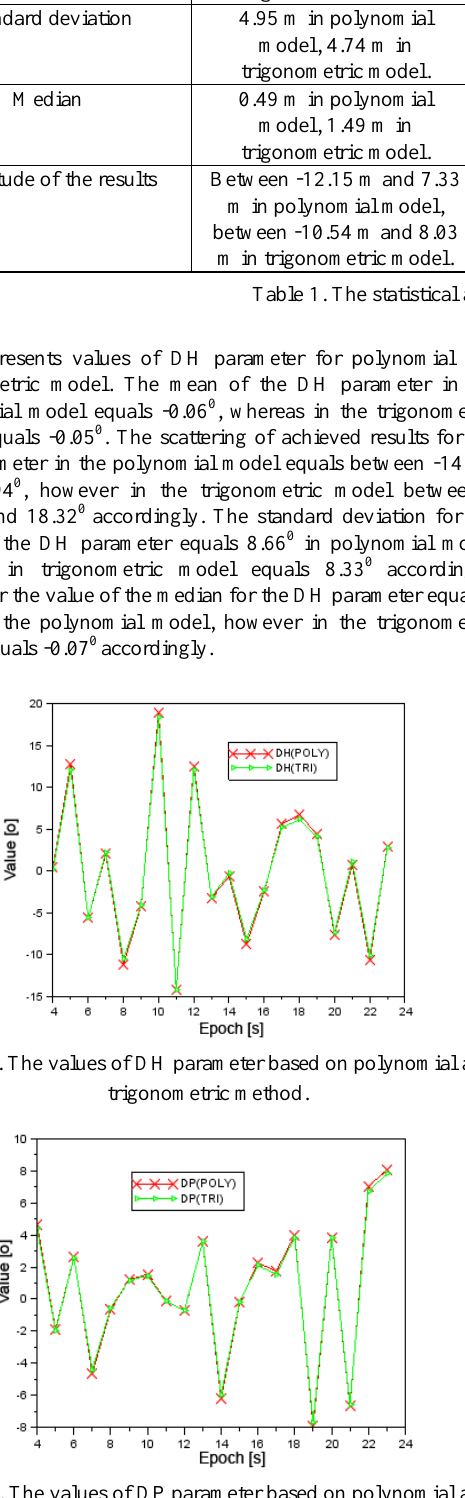
Figure 6. The values of DP parameter based on polynomial and trigonometric method.